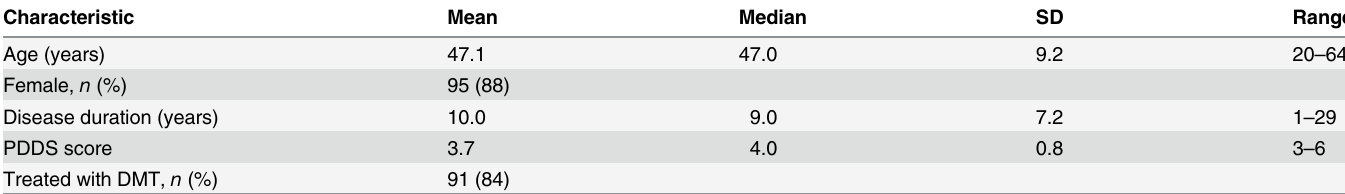
Table 1. Demographic and clinical characteristics of the sample of patients with RRMS included in the analysis ( N = 108).